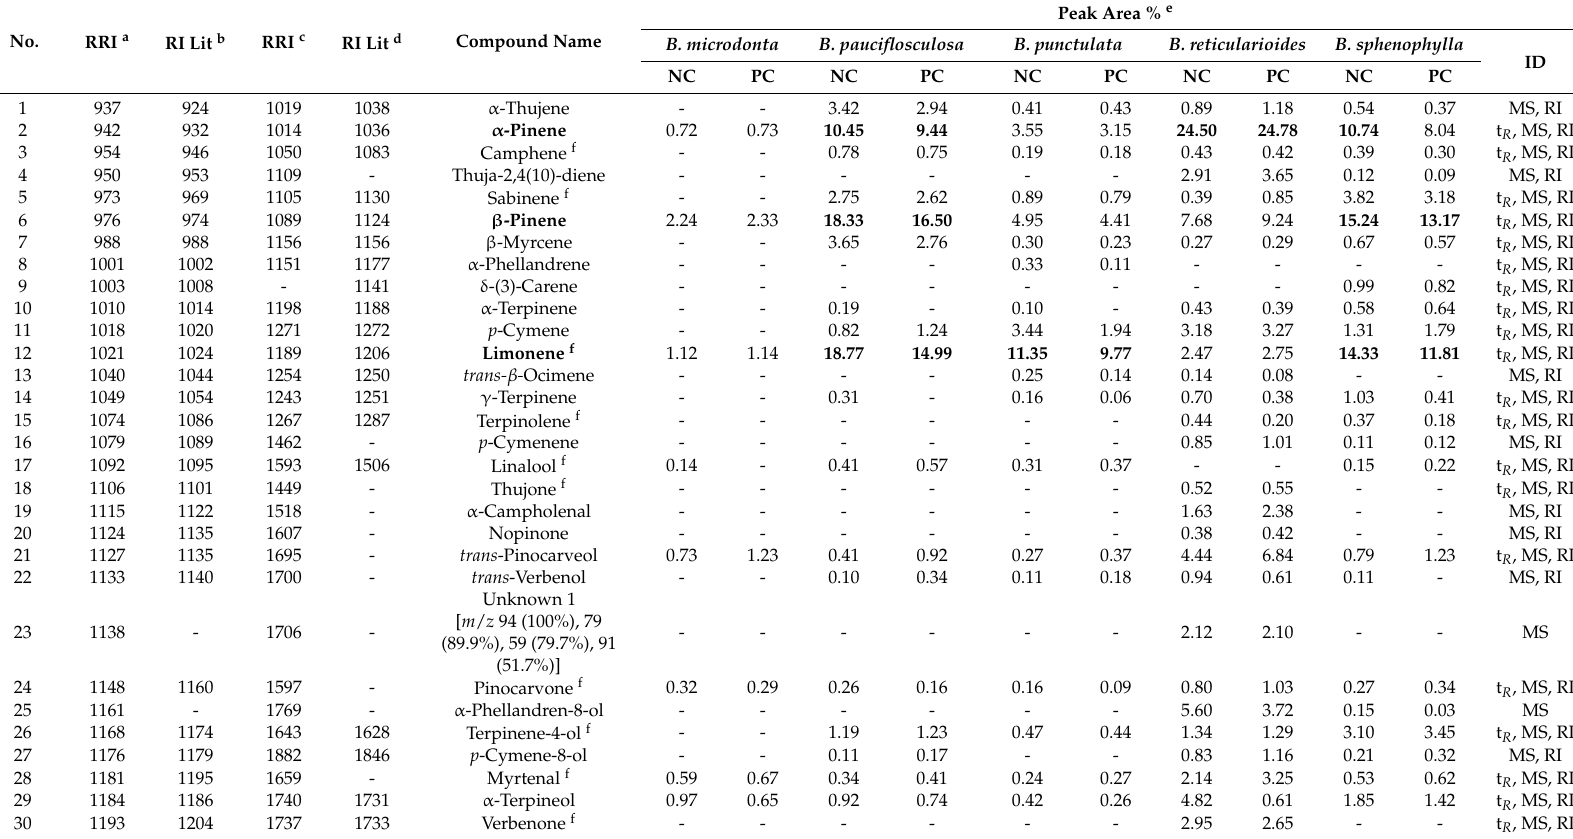
Table 1. Chemical compositions of the essential oils of Baccharis species. RRI: relative retention